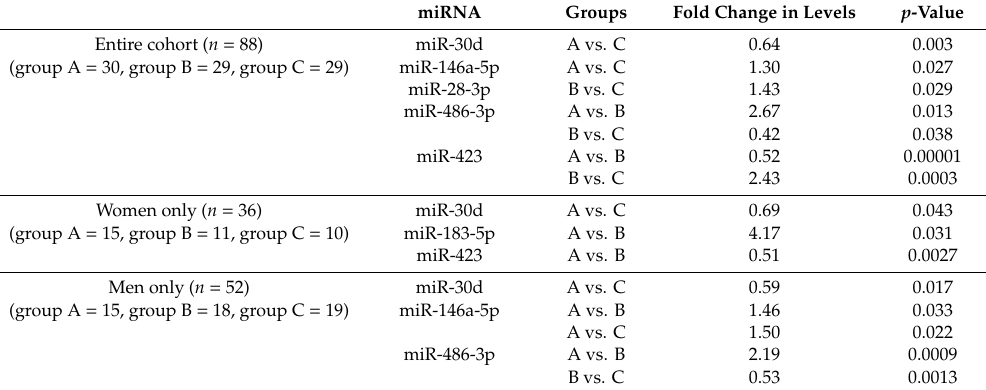
Table 2. Summary of significant ( p < 0.05, t -test) di ff erences between plasma miRNA levels in groups of subjects as indicated. Group A: Healthy volunteers; Group B: Early-stage T2DM with no known renal or vascular pathologies; Group C: Late-stage T2DM with renal and / or vascular complications. miRNA Groups Fold Change in Levels p -Value Entire cohort ( n = 88) miR-30d A vs. C 0.64 0.003 (group A = 30, group B = 29, group C =